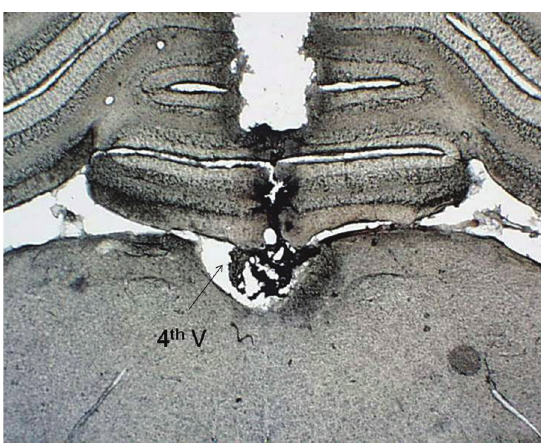
Figure 1 - Histological image of a rat brain coronal slice showing the medulla and cerebellum ( , 13 mm caudal to bregma). V4: fourth cerebral ventricle.